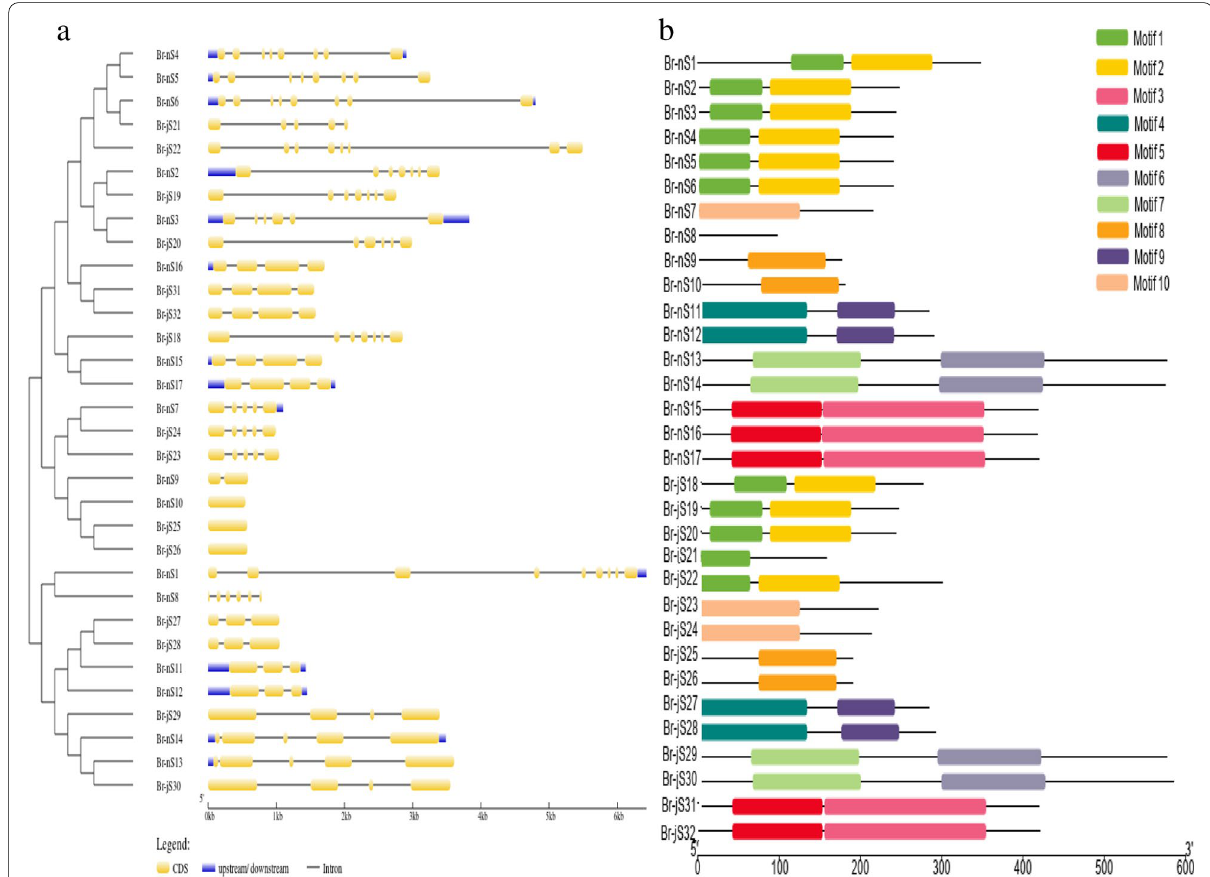
Fig. 2 a Exon–intron structure of shattering genes in B. napus and B. juncea . Exons are shown as yellow boxes, introns are shown as a thin black line, and UTRs are shown as blue boxes. b Motif distribution analysis, 10 motifs are shown as colored